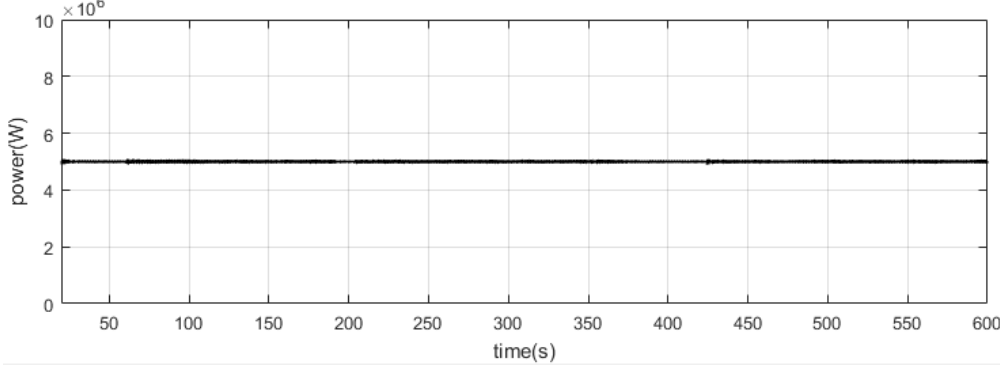
Figure 15. The final output power of the system .